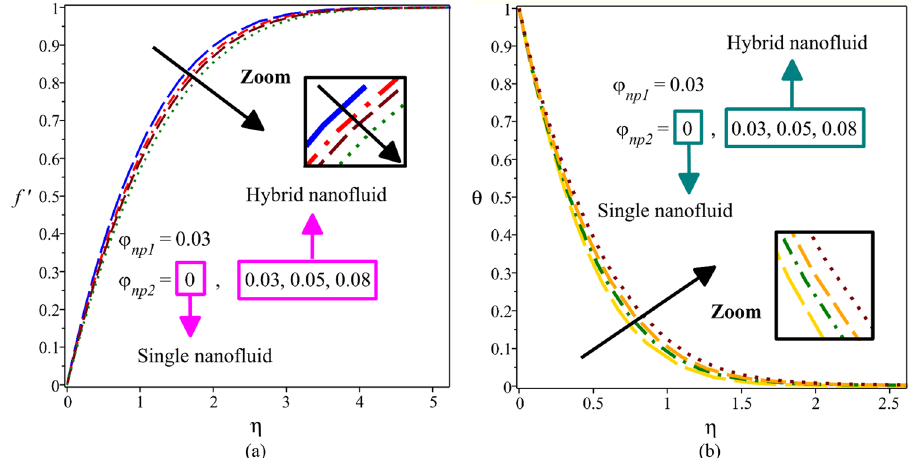
Figure 7. Velocity profile ( a ) and temperature distribution ( b ) for different values of φ np 2 .